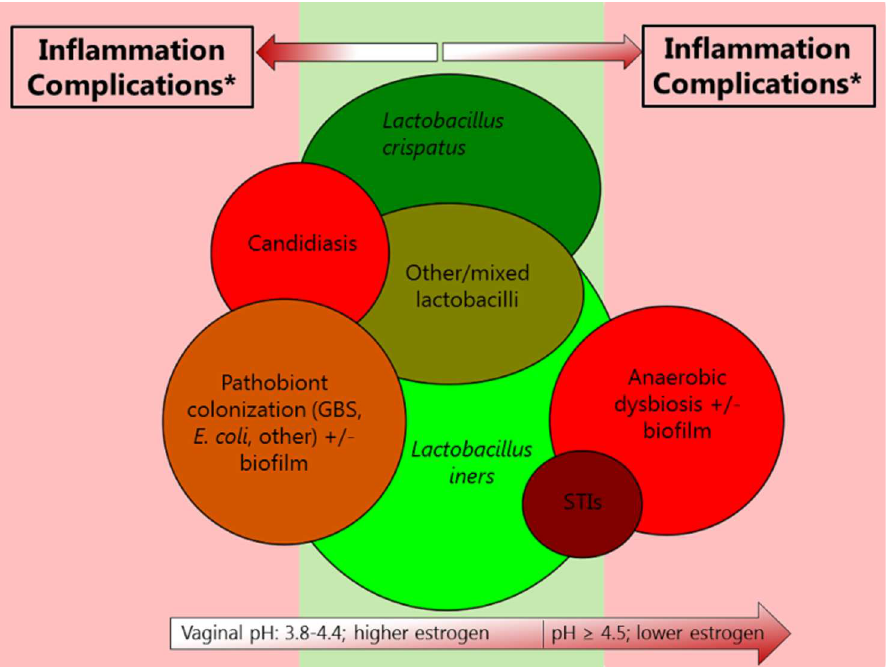
Fig 1. Visualization of interrelationships among various urogenital conditions involving micro- organisms. Green colors indicatedesirableconditions, and red colors indicate undesirable conditions. In both cases, the darker the color, the more desirableor undesirable the condition,respectively. The size of the circles is relativeto the size of the respectiveepidemics, but only very roughly. The STI circle does not include viral STIs. The circles on the far left and far right appearas if they do not overlap becausethe image is two dimensional, but they do overlap somewhat. It is important to note that few studies on the associations betweenurogenitalconditions and host responses or adverse outcomes (which determinewhethera conditionis desirableor undesirable) have been holistic. For example,many studies only employ 16S ribosomal RNA sequencing of the vaginalmicrobiota, but this does not cover fungi, protozoa,and viruses and does not reliablyidentify Chlamydiatrachomatis and Neisseriagonorrhoeae . Abbreviations: GBS, Group B streptococcus; STI, sexuallytransmitted infection. * Complications includeHIV acquisition, pelvic inflammatory disease,adverse pregnancy outcomes, and maternal and neonatal infections.